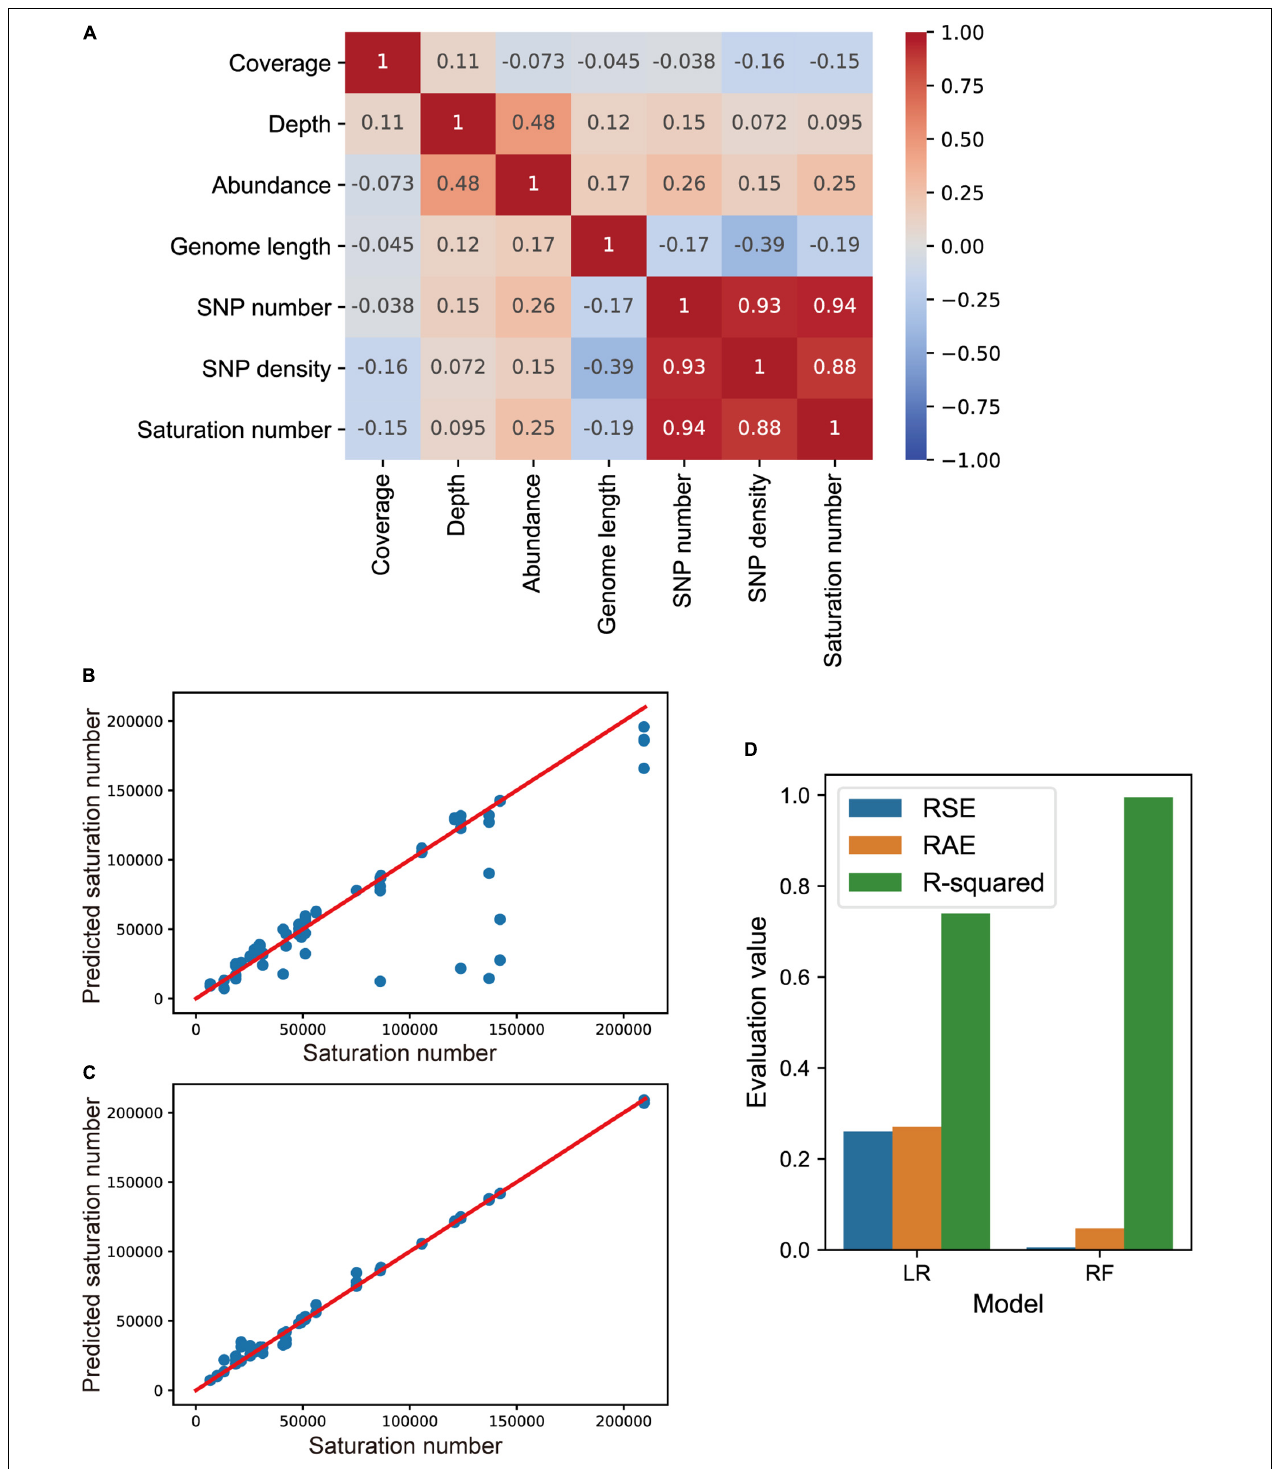
FIGURE 6 | SNP saturation prediction of strains using machine learning models. (A) Correlation heatmap among sequencing coverage, sequencing depth, relative abundance, genome length, SNP number, and SNP density of dominant strains. The SNP density equals the SNP numbers of a strain divided by the covered length of the genome. The predicted outcomes of linear regression (LR) model (B) , and random forest (RF) regression model (C) are presented. The X -axis represents the SNP saturation number of strains, and the Y -axis represents the predicted SNP saturation number. (D) The relative square error (RSE), relative absolute error (RAE) and coefficient of determination R-squared values from LR and RF models are